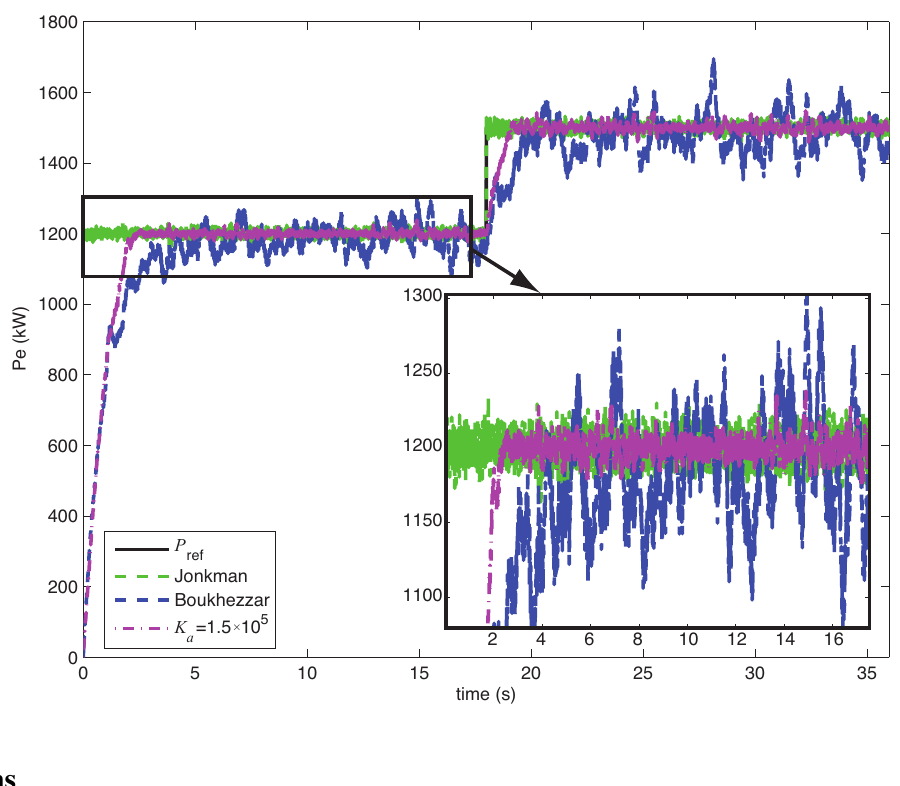
Figure 15. Power output with a white noise